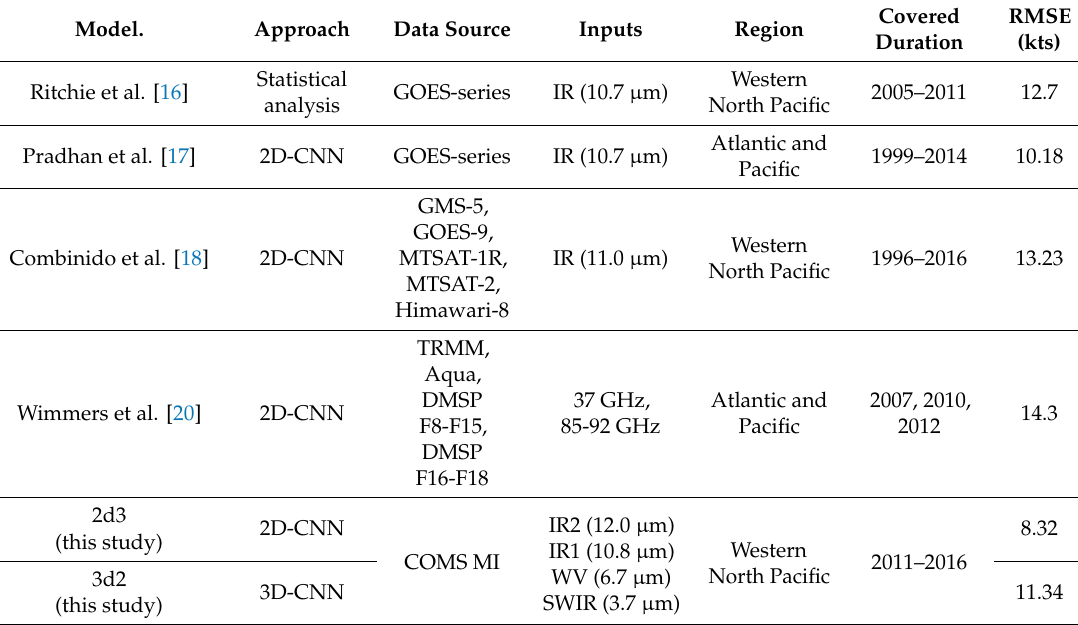
Comparison of model performances with the exiting satellite-based TC intensity estimation